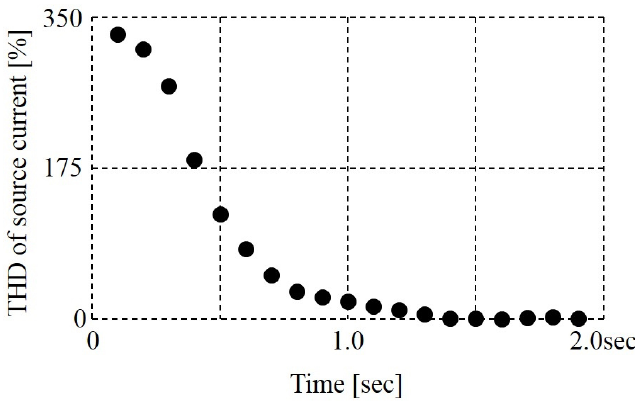
Figure 10. Source current THD of the soft-starter for the 400-kW SCIM in Figure